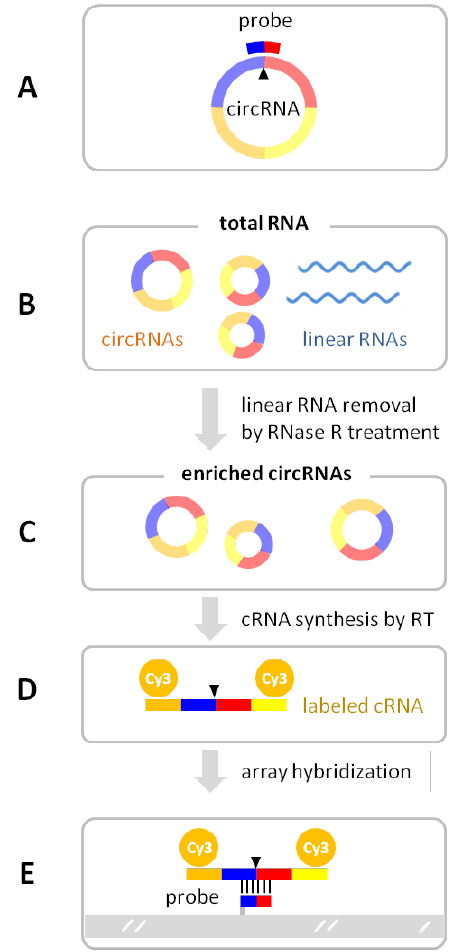
Figure 4. CircRNA microarray detection of circRNAs. ( A ) The array’s probe sequence spans the circular junction (arrow) of the circRNA. In the circRNA microarray workflow, total RNA ( B ) is treated with RNase R to selectively digest the linear RNAs so as to enrich the circRNAs ( C ). The circRNAs are copied by reverse transcriptase (RT) from the annealed random primers containing a T7 promoter. The cRNA is synthesized from the T7 promoter at the end of the cDNA template by in vitro T7 polymerase transcription, incorporating fluorescent Cy3-UTP ( D ). The fluorescent cRNA is hybridized to the probes printed on the array surface ( E ).